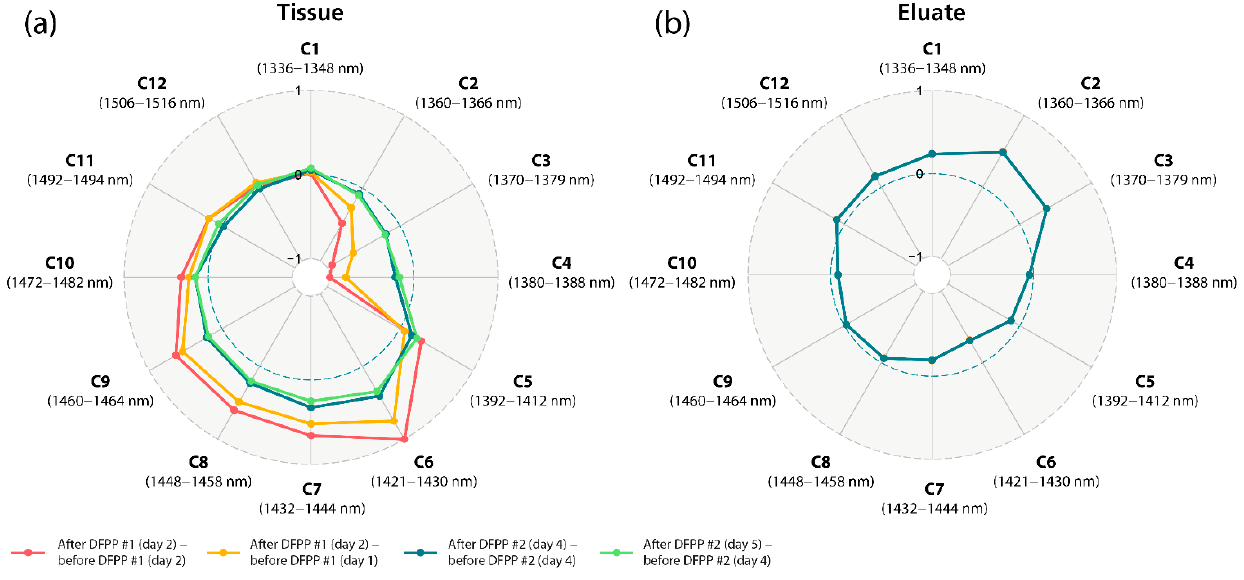
Figure 3. Aquagrams of the ( a ) tissue and ( b ) eluate spectra. The blue dashed circles refer to the zero baseline indicating no changes in the difference spectra. Note the complementary specific water absorbance spectral pattern of both aquagrams.